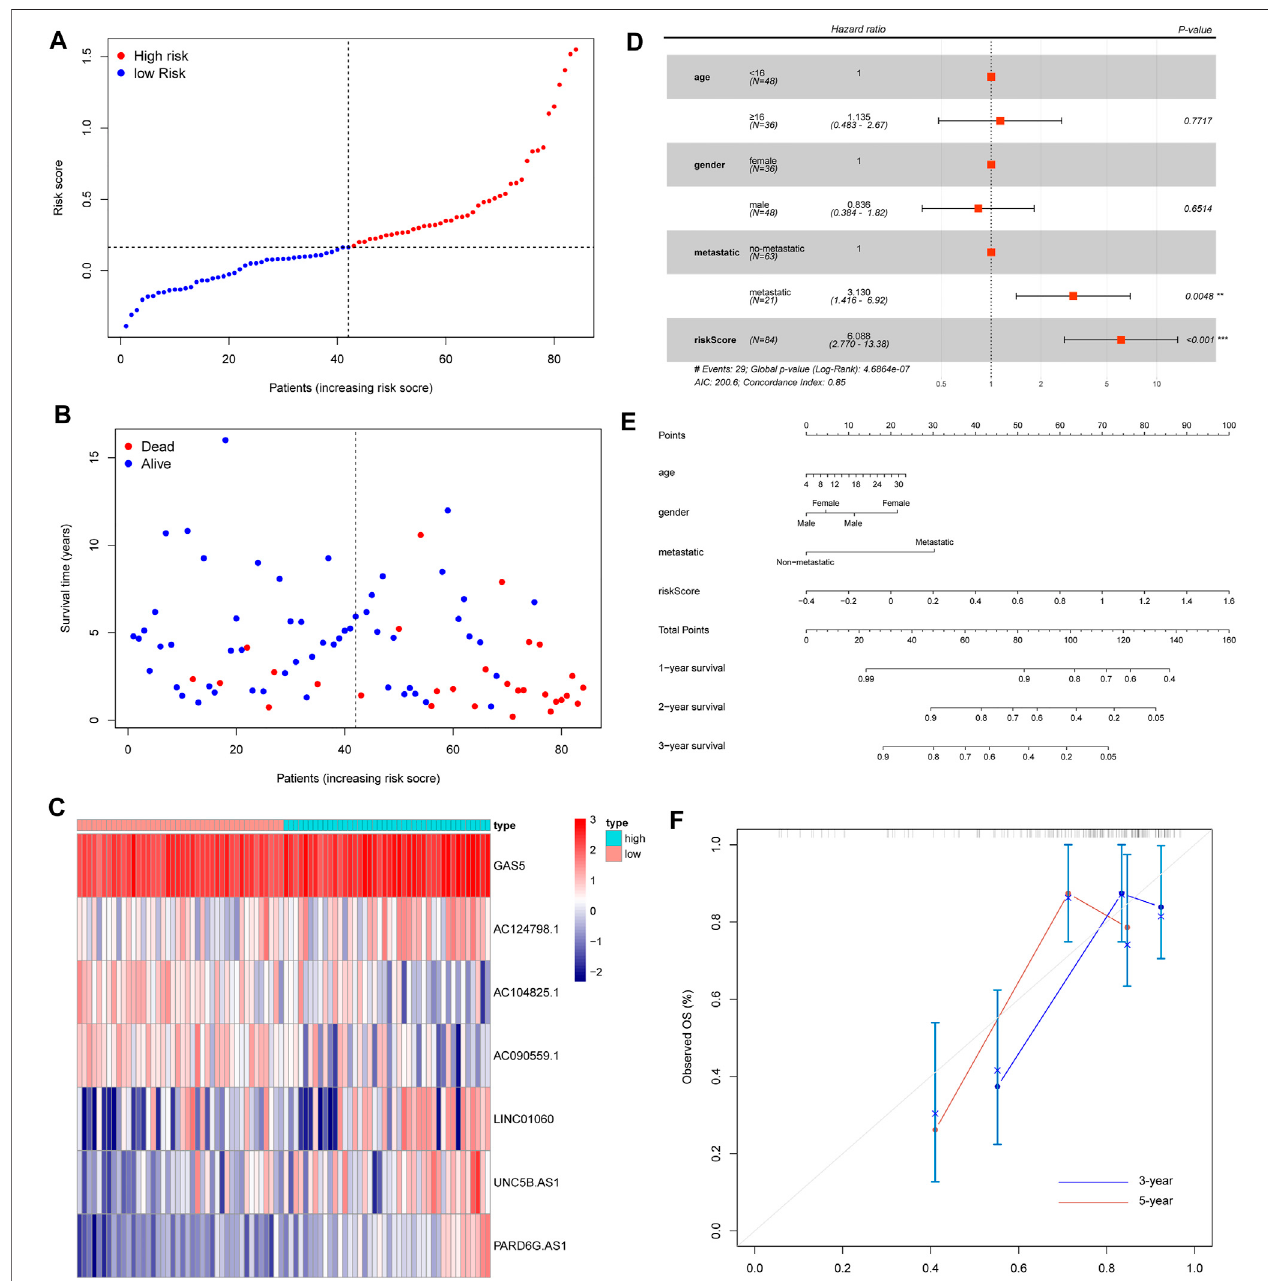
FIGURE 5 | Evaluation of an iron metabolism-related lncRNA signature. (A) Risk score distribution. (B) Survival time of OS patients. (C) Heatmap of seven iron metabolism-relatedlncRNAs. (D) MultivariateCoxanalysestoevaluatewhethertheriskscoreandclinicalfeatureswereindependentprognosticindicatorsfortheoverall survival of OS patients. (E) Nomogram for predicting 1/3/5-year survival rates of OS patients. (F) Calibration curve of the nomogram for 3/5-year survival rates.